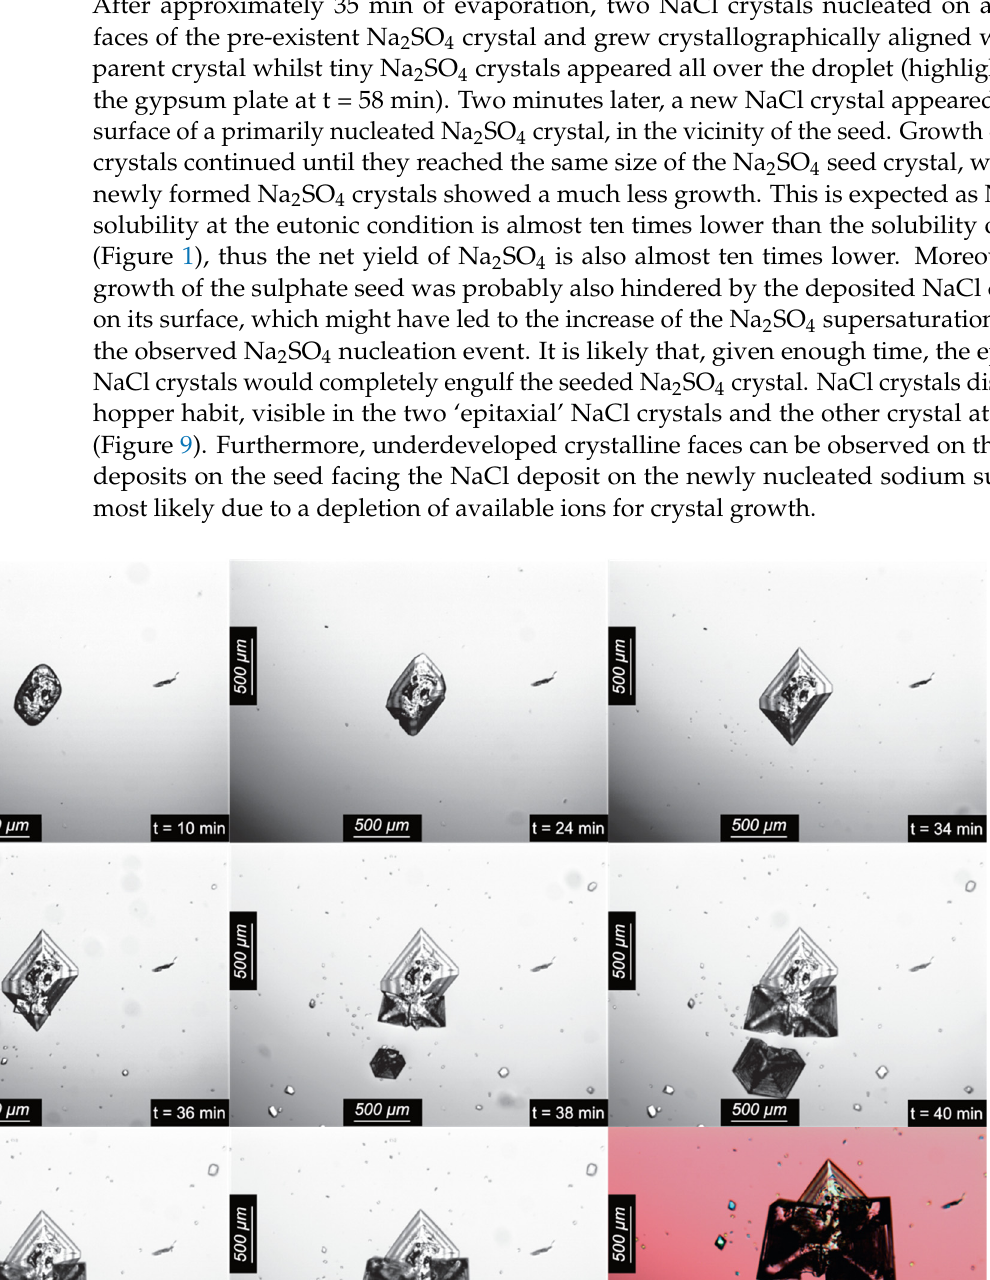
2 SO 4 –H 2 O droplet under evaporation seeded with Na 2 SO 4